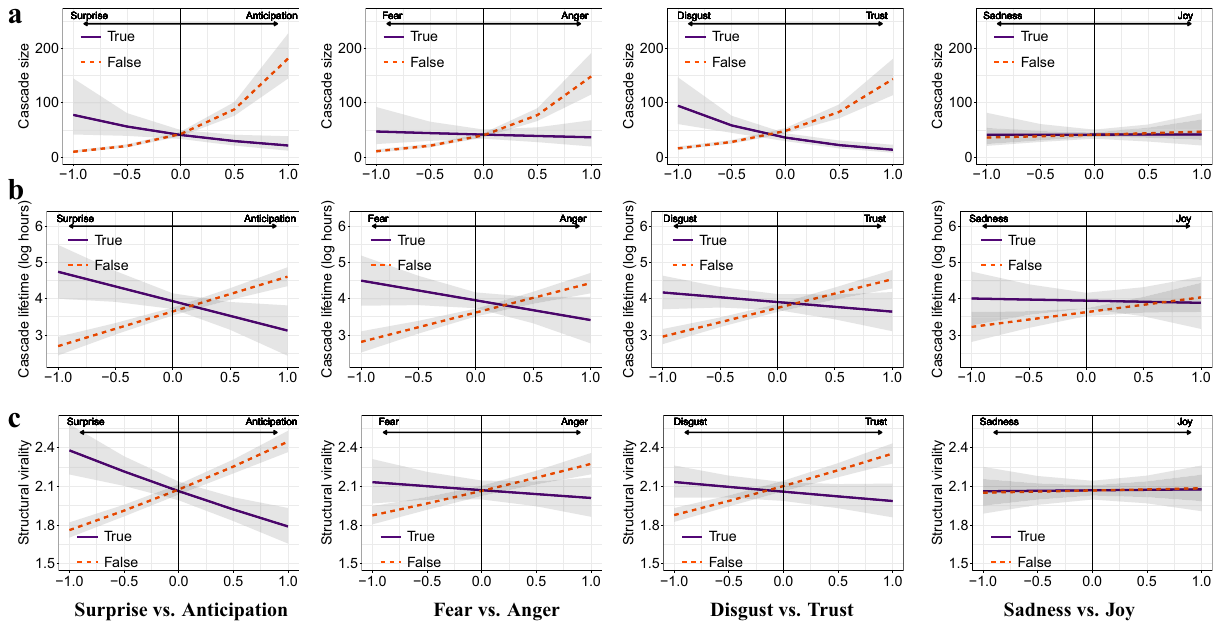
Figure 7. Predicted marginal effect of language classified by bipolar emotions on cascade size ( a ), cascade lifetime ( b ), and structural virality ( c ). The 95% confidence intervals are highlighted in